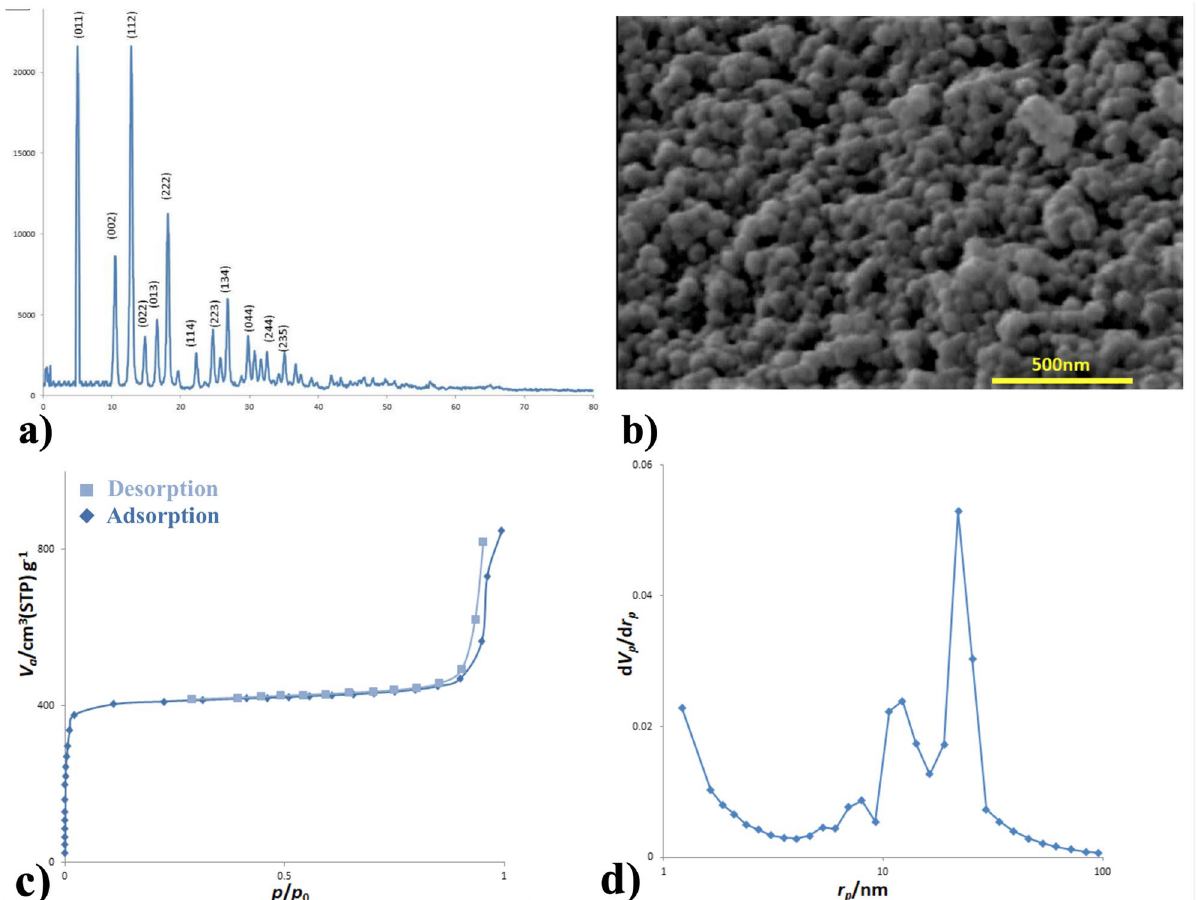
Figure 1. Chracteristics of synthesized MOF particles. ( a ) XRD pattern. ( b ) SEM image. ( c ) Nitrogen absorption/desorption isotherms. ( d ) BJH